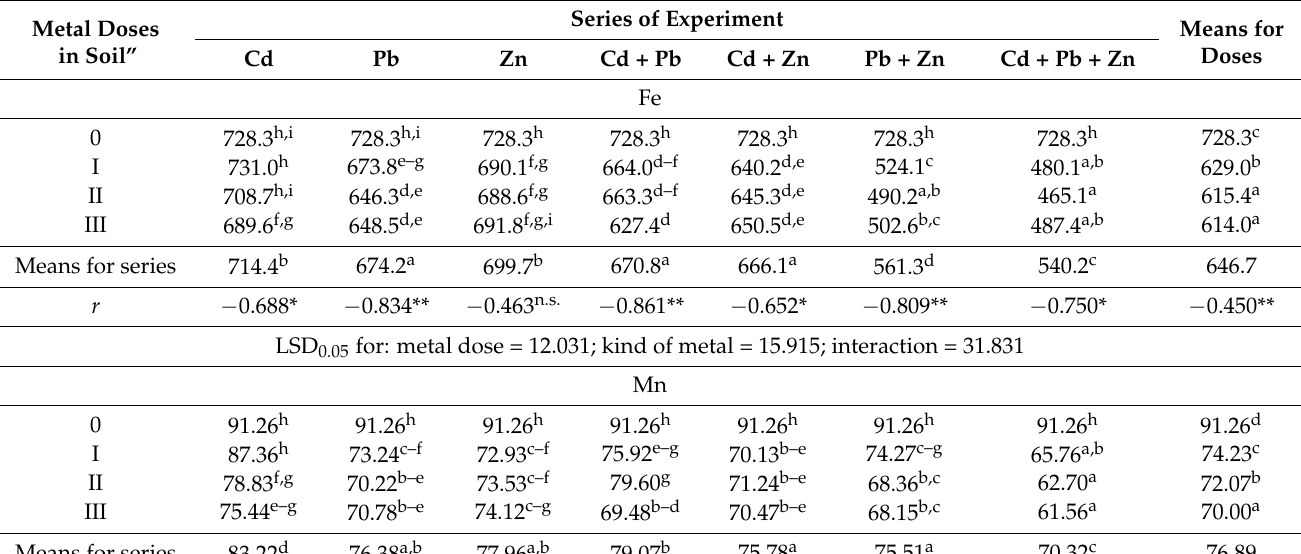
Table 2. Content of available forms of Fe, Mn and Cu, in mg kg − 1 of